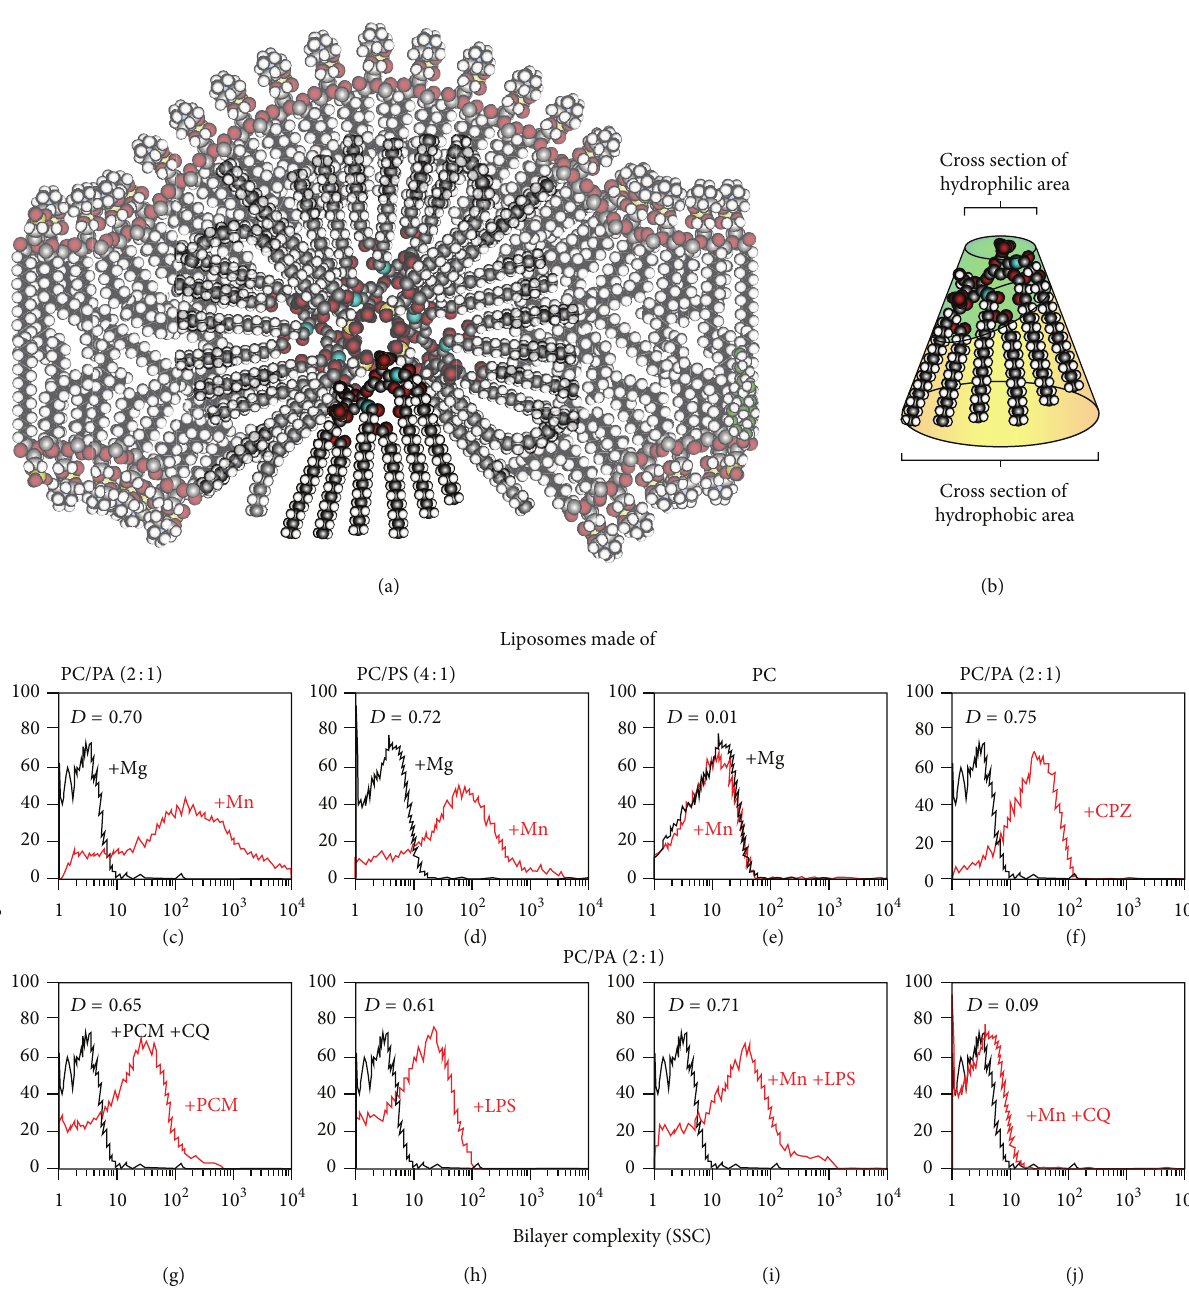
Figure 1: Structure and characterization of nonbilayer phospholipid arrangements. (a) Representation of a nonbilayer phospholipid arrangement, showing an inverted micelle, with the acyl chains of the phospholipids in a conical arrangement, inserted into the lipid bilayer. (b) Molecular shape of the lipid A of LPS, showing the conical arrangement of its acyl chains. (c to j) Liposomes made of egg- yolk phosphatidylcholine (PC)/egg-yolk phosphatidic acid (PA) (2 :1 molar ratio), PC/bovine brain phosphatidylserine (PS) (4: 1) (50 nmol anionic phospholipid in 50 𝜇 L TS buffer), or PC alone were incubated at 37 ∘ C for 30 min with 2 mMMnCl 2 , 1.5mM chlorpromazine (CPZ), 8 mM procainamide (PCM), 100 ng/mL LPS, 0.1mM chloroquine (CQ), 0.2 mMMgCl 2 , or the indicated mixtures of cations or compounds, respectively. Changes in bilayer complexity (SSc) are represented as histograms: black lines represent liposomes alone or incubated with Mg or PCM + CQ; red lines represent liposomes incubated with Mn or the indicated compound. Values of Kolmogorov-Smirnov test of 𝐷 ≥ 0.5 , 𝑝 < 0.001 , indicate a significant difference between the compared histograms. A representative experiment of five is